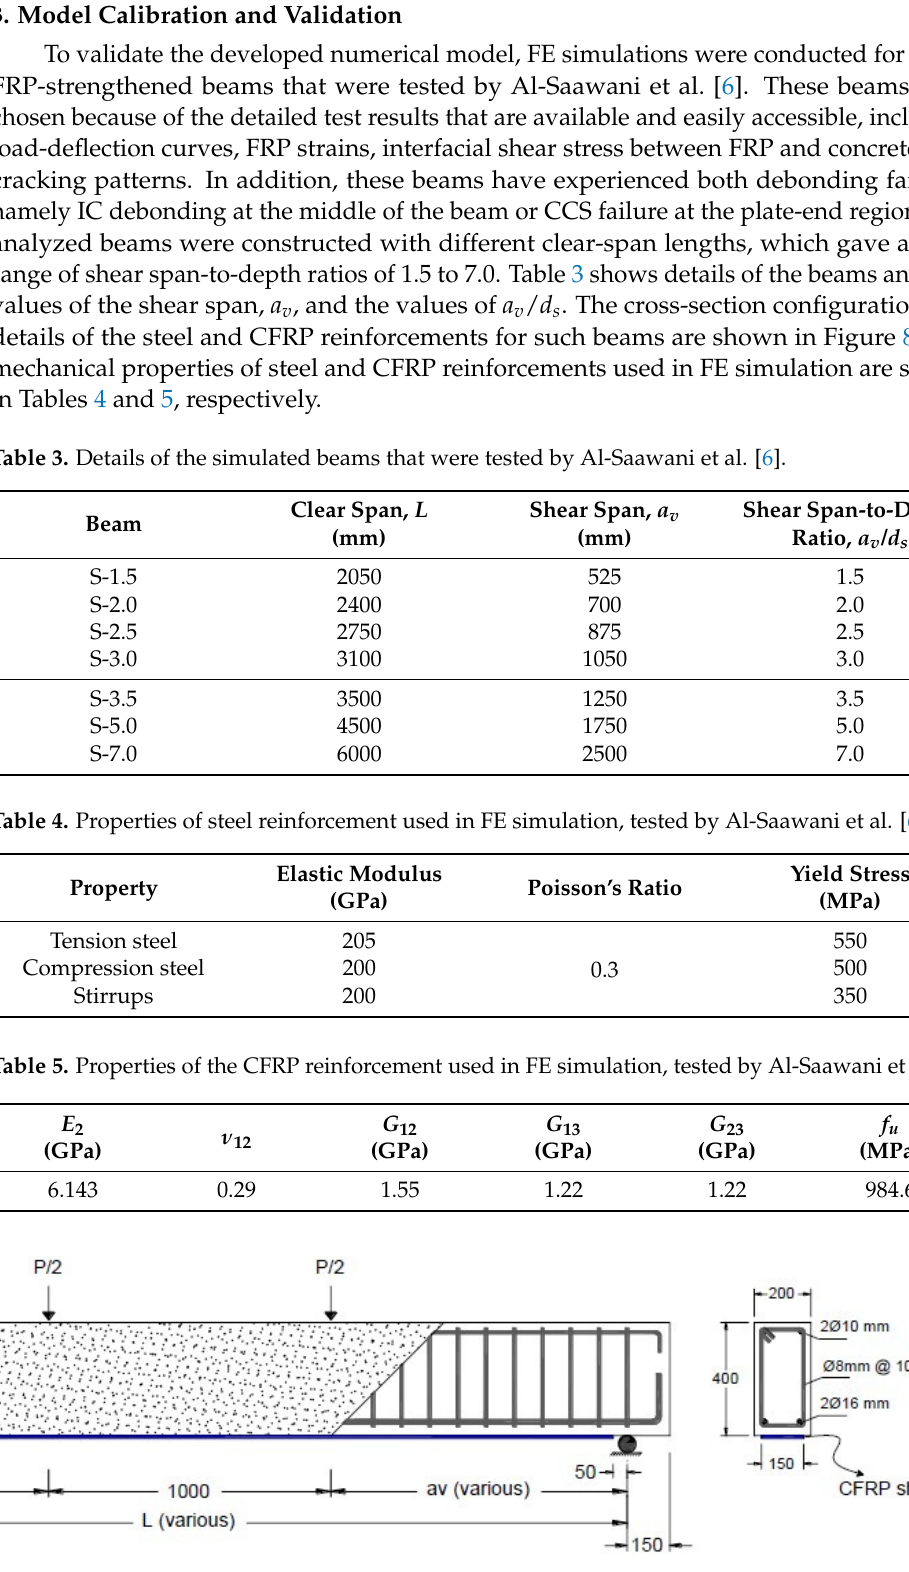
Figure 8. Geometry and reinforcement details of the analyzed beams Table 4. Properties of steel reinforcement used in FE simulation, tested by Al-Saawani et al. [6]. 371